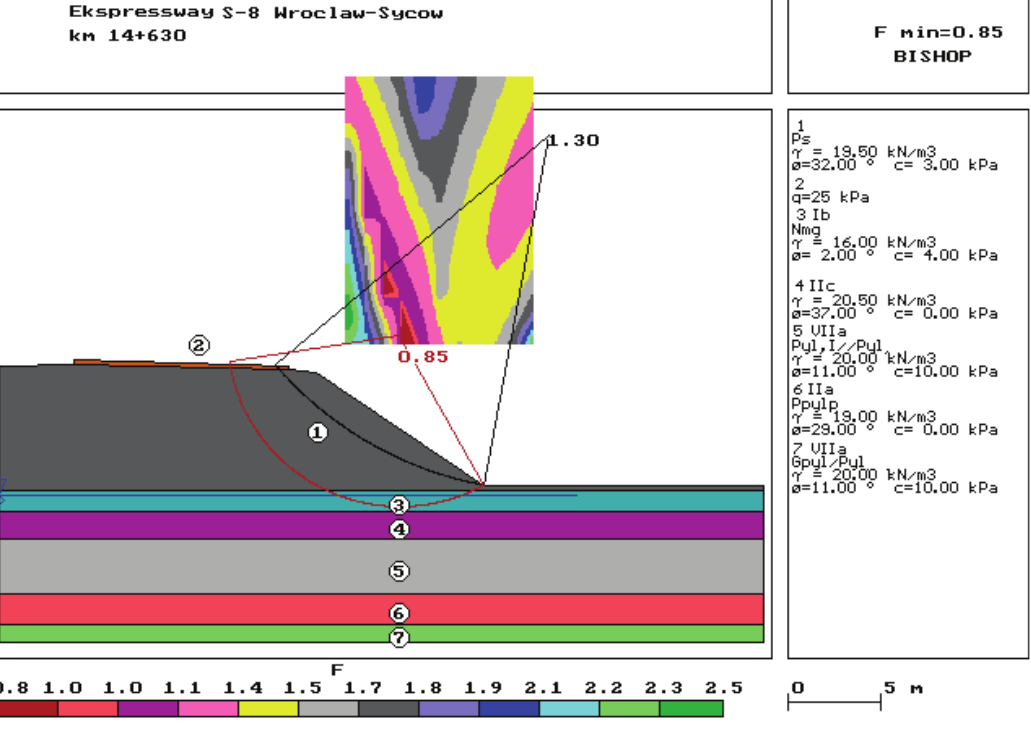
Figure 3a: Expressway S-8 Wrocław-Syców, cross-section at km 14 + 630 – embankment placed directly on the layer of silts (stability assessment performed according to [21]).